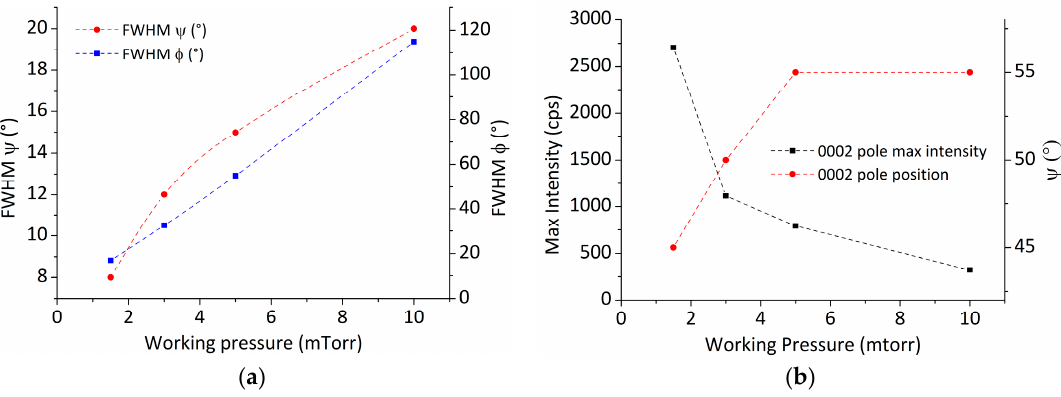
Figure 4. Plots showing AlN (0002) ( a ) peak full width at half maximum (FWHM) along ψ and φ and ( b ) peak intensity with corresponding polar position at different working pressures.